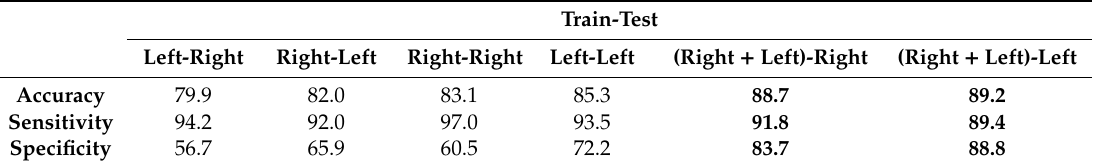
Table 4. Average testing accuracy (acc.), sensitivity (sens.), and specificity (spec.) for six train-test combinations. LOSO evaluation